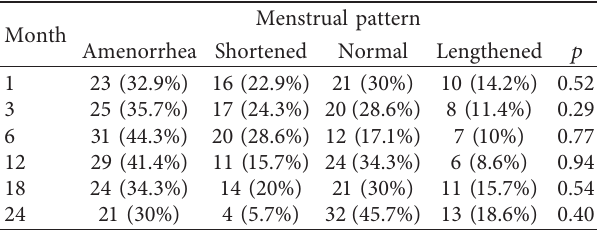
Table 2: Characteristics of menstrual pattern in one-rod users.